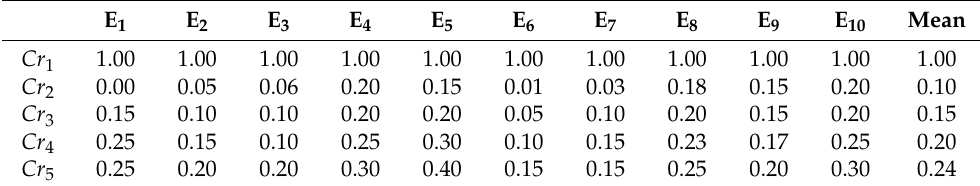
Table 1. Attitudes of respondents as results of the SWARA